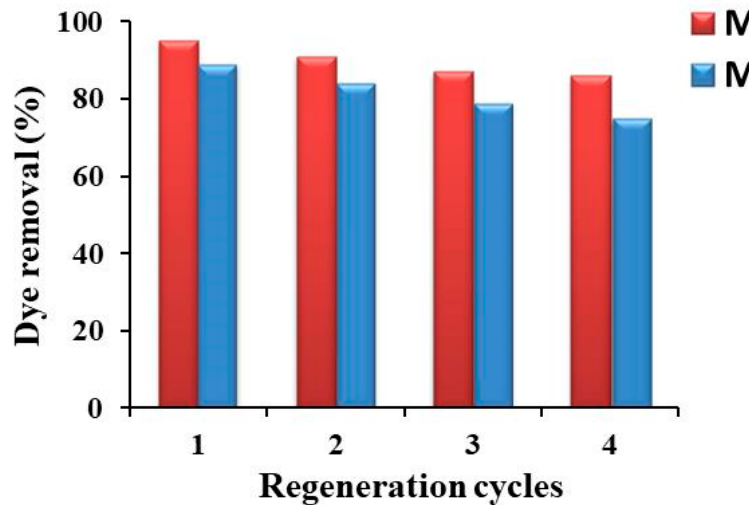
Figure 8. Percentage of MB and MO removal during the adsorption/desorption cycles.